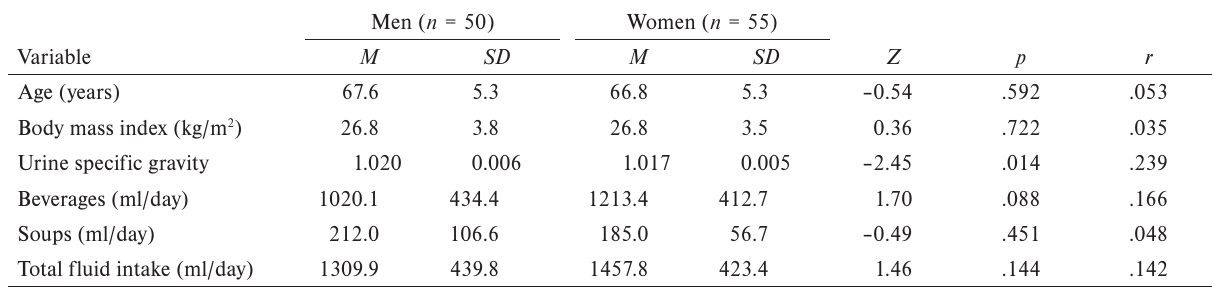
Characteristics of the sample stratified by gender (N = 105)